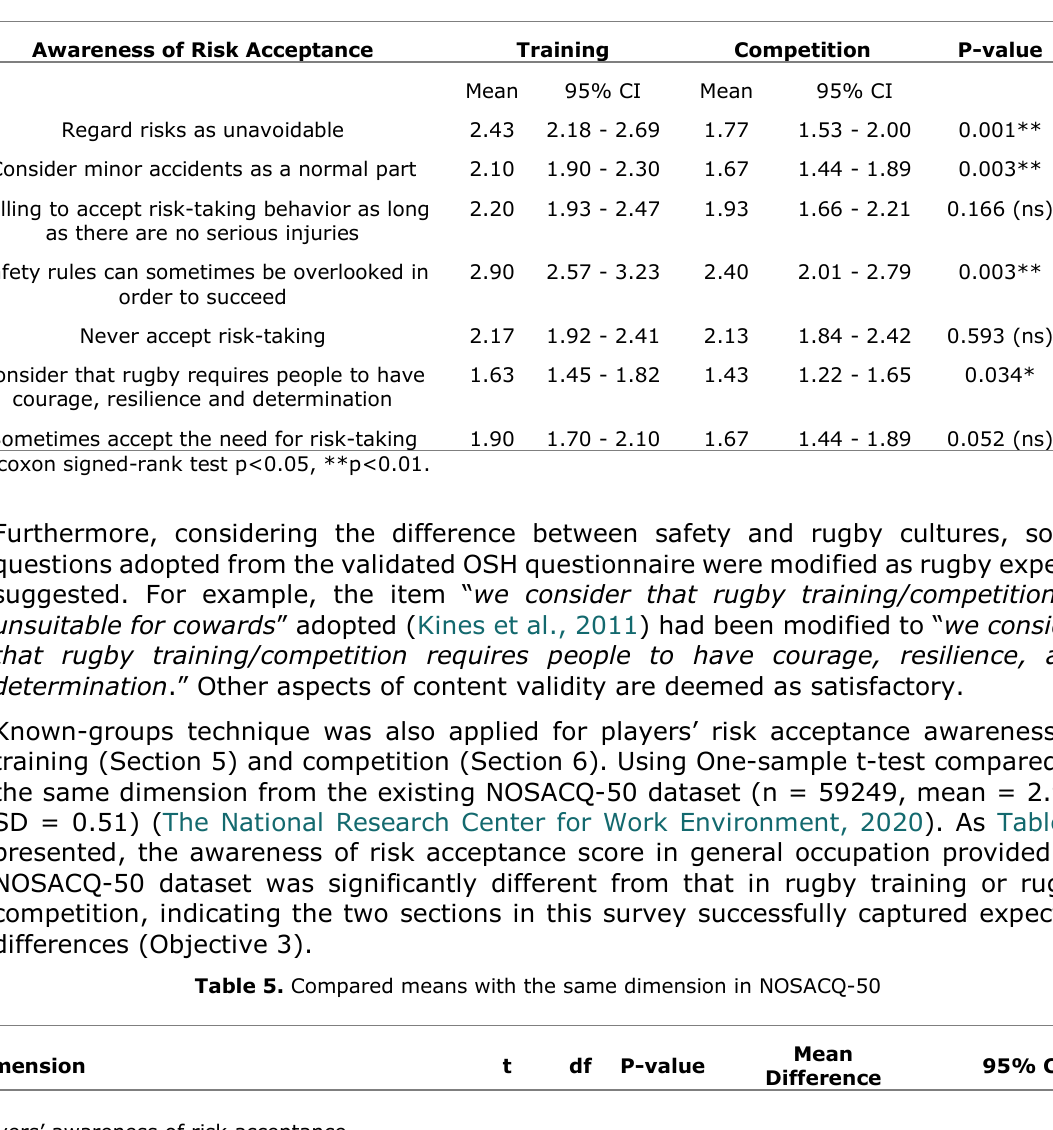
Table 4. The score of players’ awareness of risk acceptance (n=30)